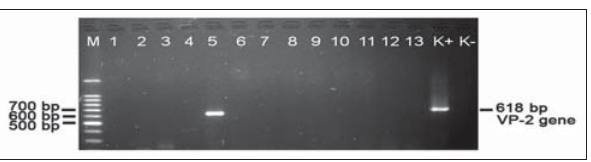
Figure-1: Electrophoresis of avian encephalomyelitis products of viral protein-2 gene from avian encephalomyelitis virus in agarose gel 1.5%. Fragments DNA of amplification products has the size of 619 bp. M is DNA ladder 100 bp, lane 1-13 are samples, K+ is positive control and K − is negative control. Sample No. 5 (sample code 499/4/12) is positive sample.